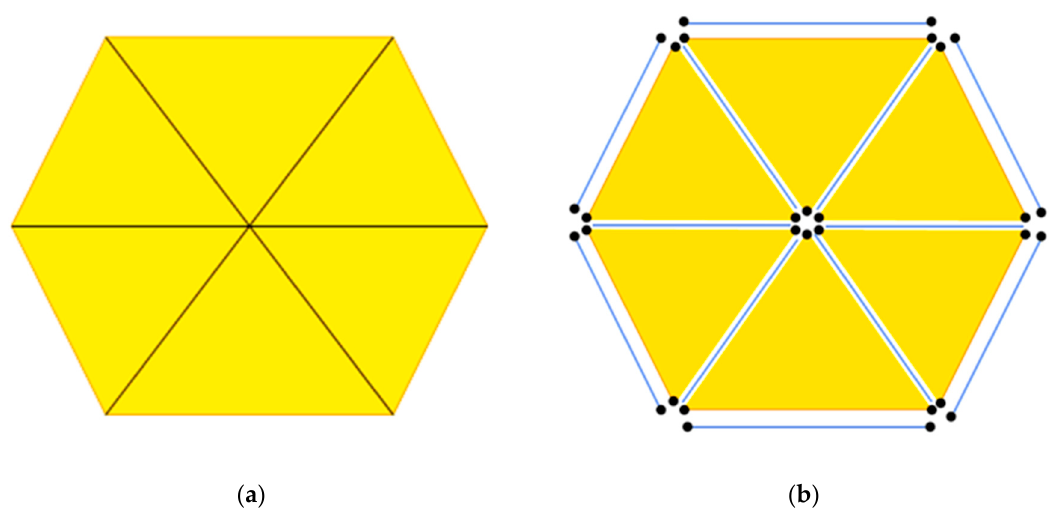
Figure 8. The cohesive element inserting algorithm; ( a ) six triangular elements before inserting and ( b ) reset nodes and cohesive elements after inserting.